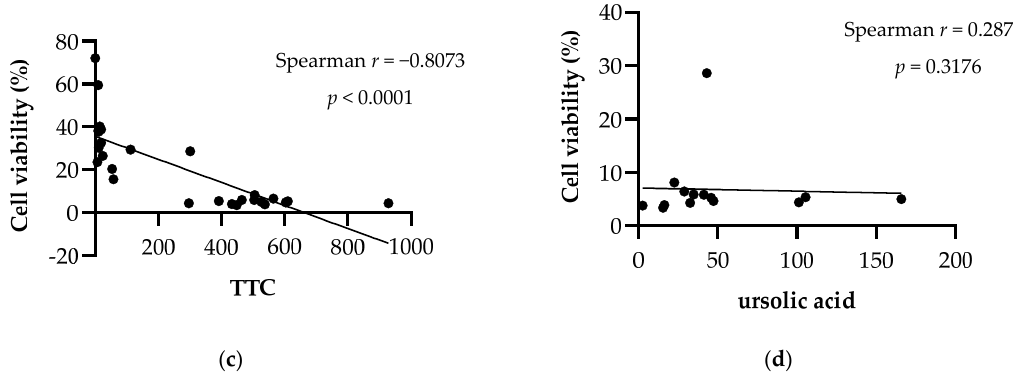
Figure 3. Spearman’s correlation between cytotoxic effects of extracts against MDA-MB-231 cells and their phytochemical content. ( a ) TIC: Total iridoid content (mg aucubin equivalents/g extract). ( b ) TSC: Total sterol content (mg cholesterol equivalents/g extract). ( c ) TTC: Total triterpenoid content (mg oleanolic acid equivalents/g extract). ( d ) Ursolic acid (mg/g extract). Triterpenes are important natural compounds with anti-cancer and chemopreventive effects. They not only inhibit the survival of neoplastic cell lines, but also induce apoptosis in cancer cells, without affecting normal cells [56]. The most common triterpene identified in the genus Nepeta is ursolic acid. In addi-